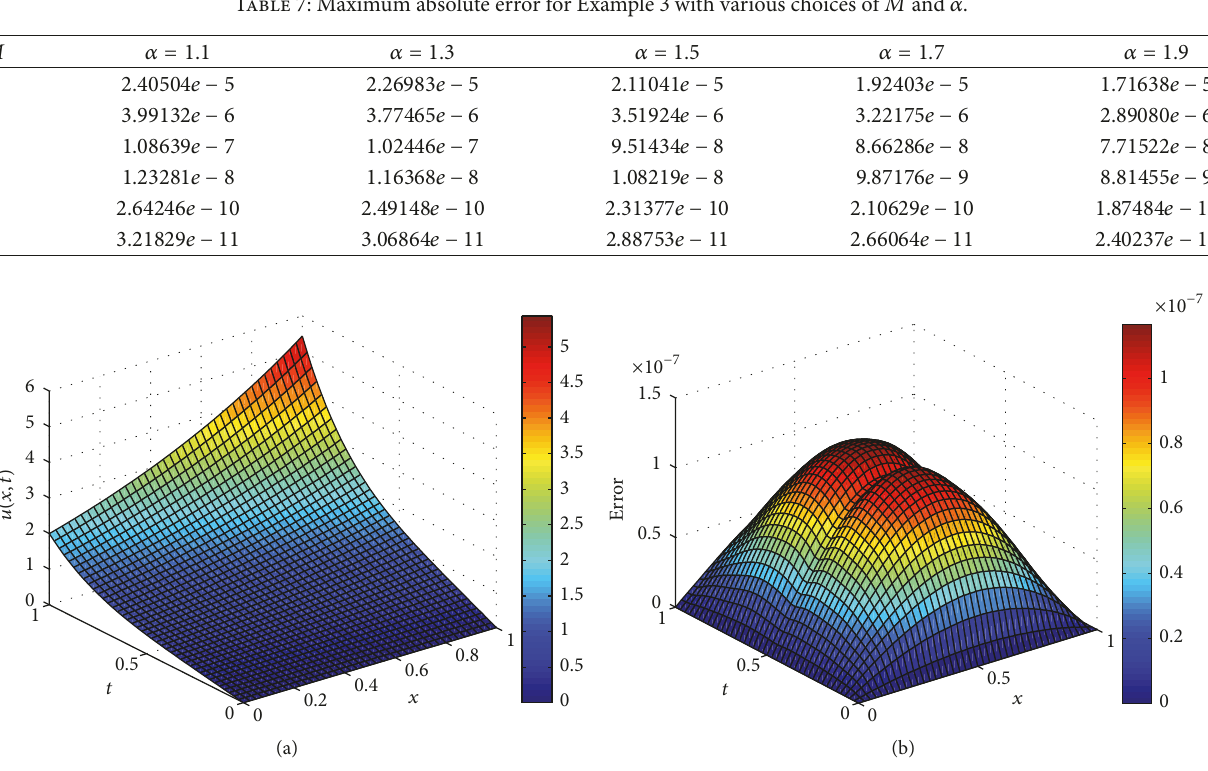
Figure 4: Approximate solution (a) and absolute error (b) for Example 4 with 𝛼 = 1.9 , 𝑘 = 2 , and 𝑀 = 6